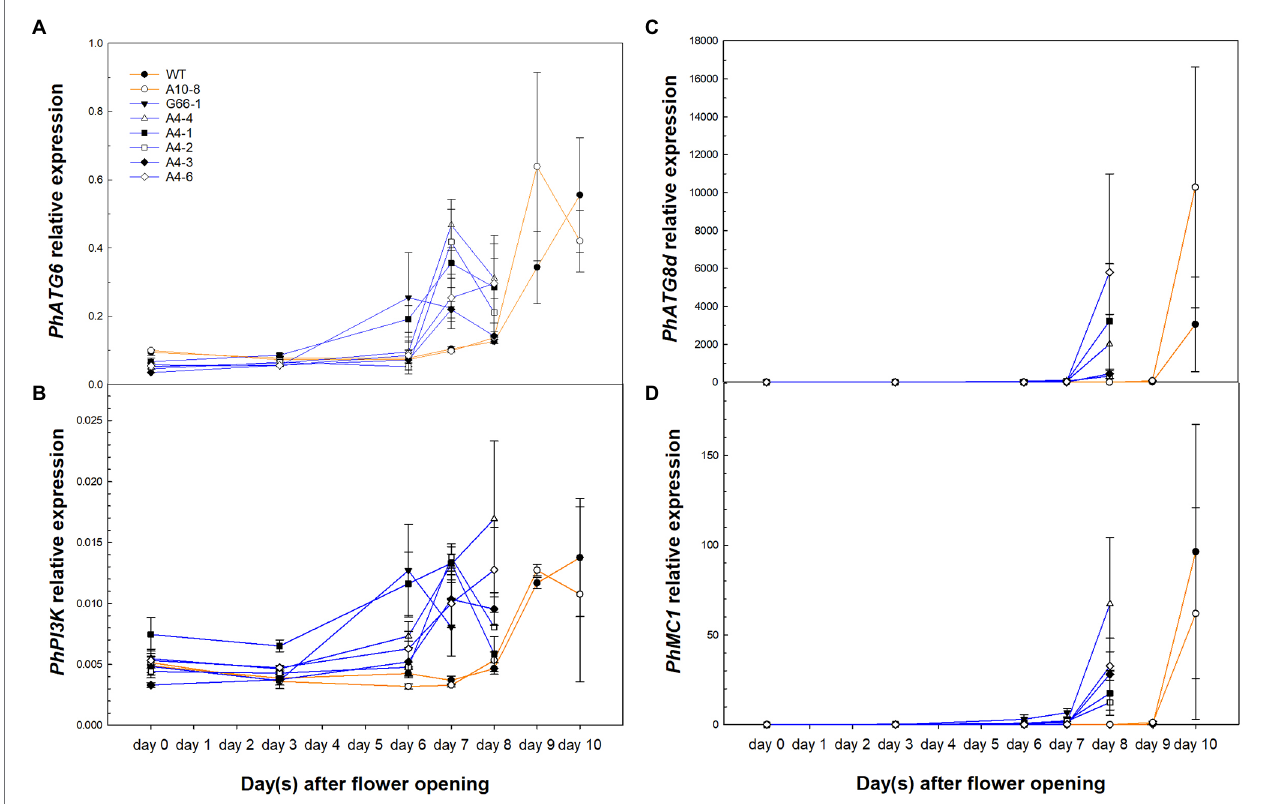
FIGURE 6 | Relative expression of PCD-related genes Autophagy Gene 6 ( PhATG6 , A ), Phosphoinositide 3-Kinase ( PhPI3K , B ), Autophagy Gene 8d ( PhATG8d , C ), and Metacaspase 1 ( PhMC1 , D ) in the corollas of Petunia × hybrida ‘Mitchell Diploid’ wild-type plant (WT), non-mutated regenerated line A10-8, and PhATG6 - KO lines from flower opening to senescence ( n = 2). Orange lines represent the results of controls (WT and line A10-8), and blue lines represent the results of the PhATG6 -KO lines. The relative expression was calculated based on the expression of reference genes PhActin and PhSAND . Data represent the means of the measurements ± standard